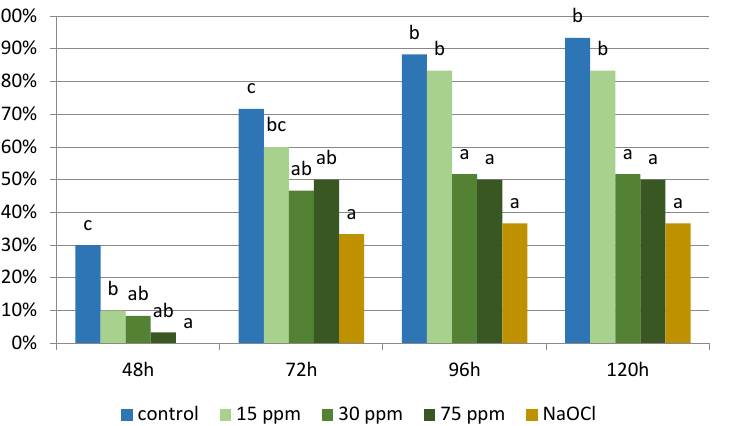
Figure 6. Rate of infections of tomato seed after immersion in solutions of different concentrations of silver nanoparticles (75 ppm, 30 ppm and 15 ppm) or sodium hypochlorite (NaOCl). The control sample was treated with sterile water. Treatments were compared using analysis of variance and Fisher’s LSD test for each term separately. Parameters in columns denoted with the same letters (a. b. c.) do not differ statistically at the confidence level of p < 0.05.